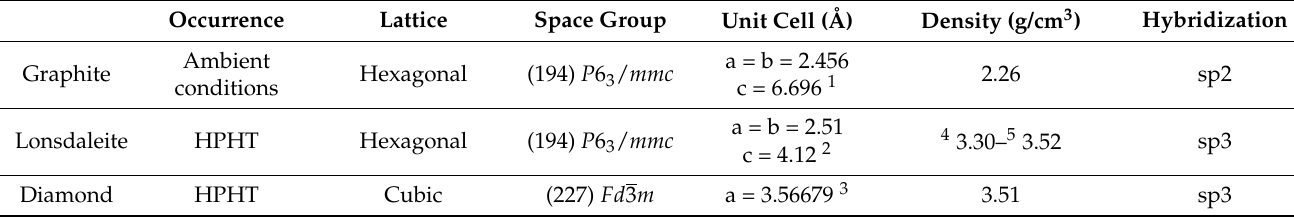
Figure 1. Crystal structures of the three natural forms of carbon. From left ( a ) to right ( c ), i.e., with increasing pressure and temperature, ( a ) graphite (black), ( b ) lonsdaleite (dark grey) and ( c ) diamond (light grey). Graphite and lonsdaleite have hexagonal structure, whereas diamond is cubic. Graphite has a sp2 hybridization, whereas lonsdaleite and diamond have an sp3 one. Table 1. Lattice parameter of the three natural forms of carbon 1,3 from [6] 2 from [7] 4 , measured 5 , calculated.